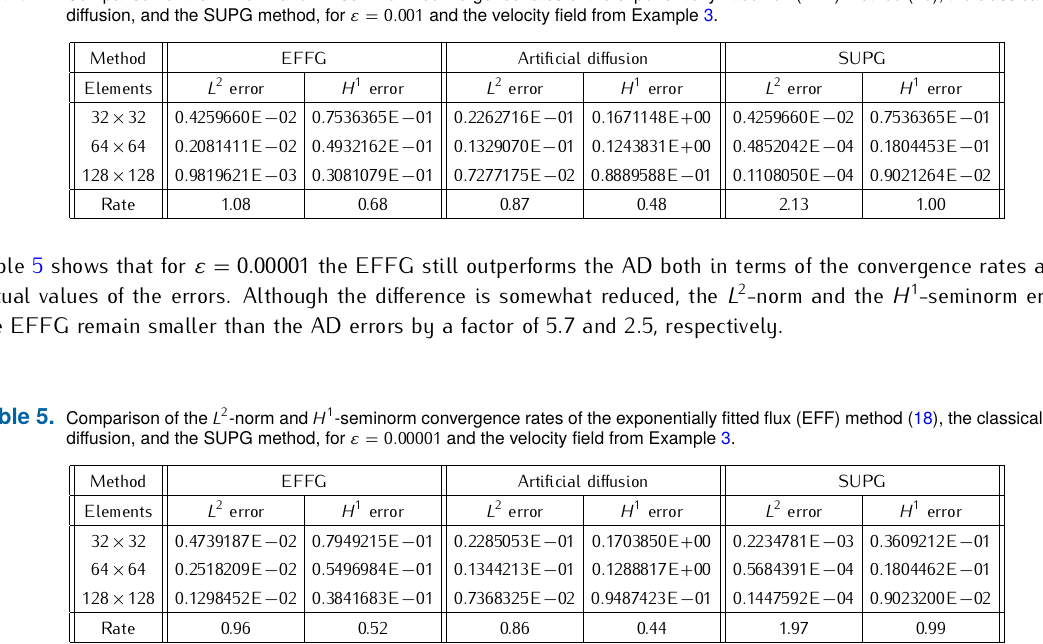
Table 4 presents the convergence rates for ε = 0 . 001. As expected, the EFFG rates are lower than the rates of the SUPG, which is a consistent formulation. However, the EFFG rates are noticeably better than the AD rates and the EFFG errors are smaller than the AD errors on all grids. In particular, on the finest 128 × 128 grid the L 2 -norm and the H 1 -seminorm errors of the EFFG are smaller than the corresponding AD errors by a factor of 7 . 4 and 3, respectively.